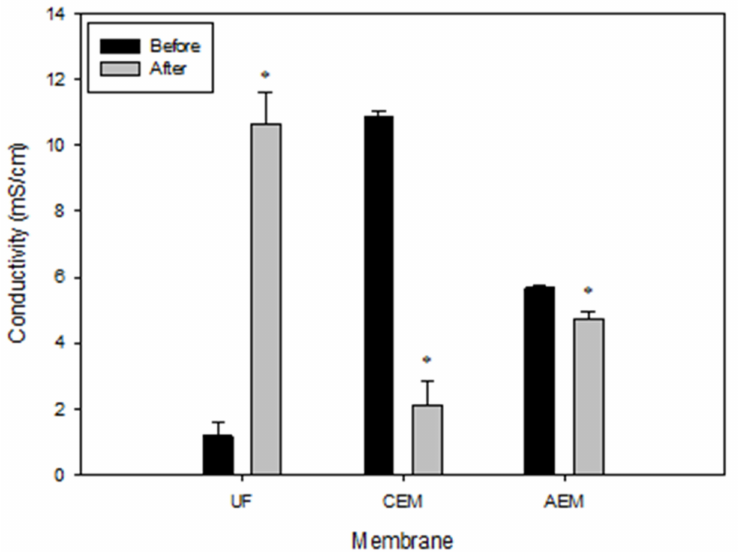
Figure 9. Average conductivity for ultrafiltration (UF), cationic (CEM), and anionic (AEM) mem- branes before and after the EDUF process. T-test was performed at p ≤ 0.05. * over a band means a significant